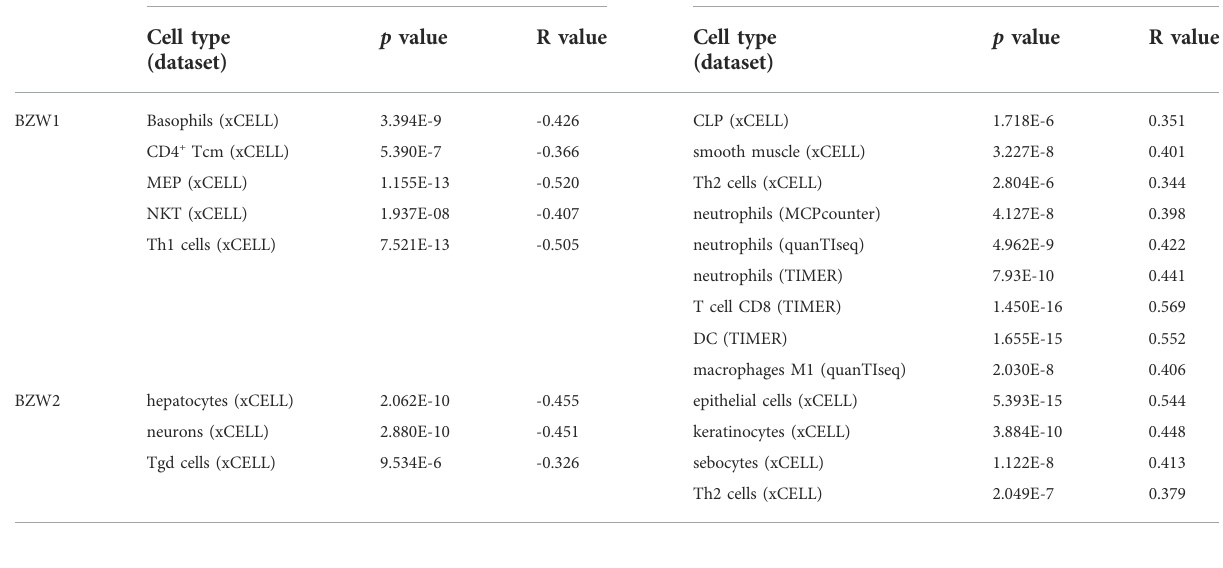
TABLE 2 Correlations between BZW1/2 expression and TIICs in PAAD (Pearson).